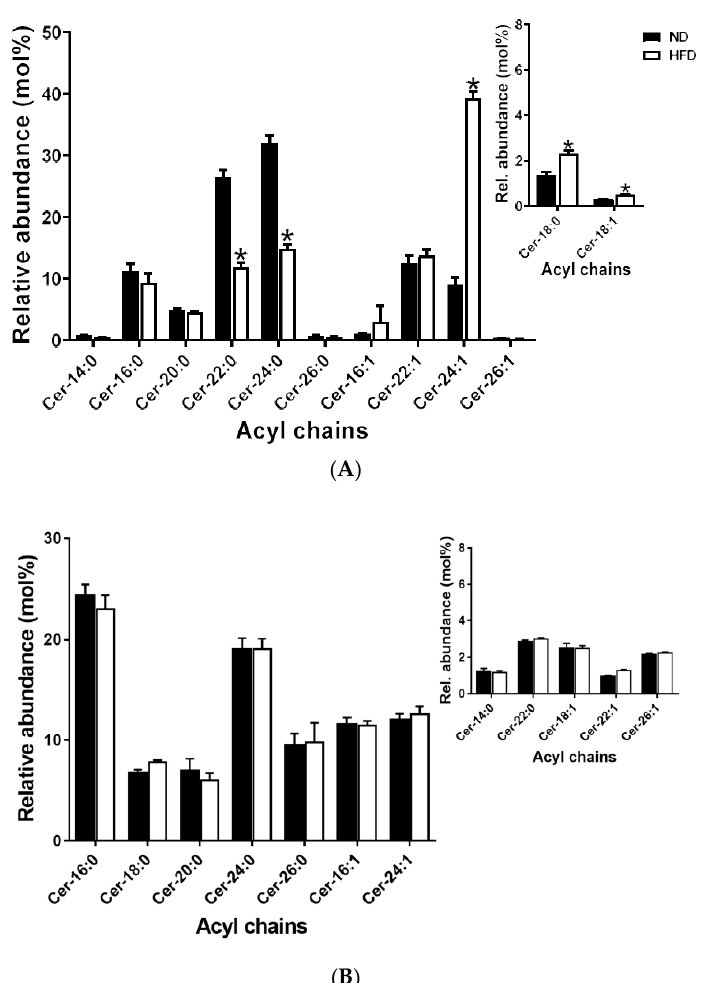
Figure 7. ( A ) Plasma ceramide species detected; inset shows species with low relative abundance. Data are expressed as means ± SEM, * p < 0.05. Asterisks indicate a significant difference compared to the matched ND value. ( B ) Meibum ceramide (Cer) species detected; inset shows species with low relative abundance. Data are expressed as means ± SEM and no significant difference was recorded. Int. J. Mol. Sci. 2020 , 21 , x FOR PEER REVIEW